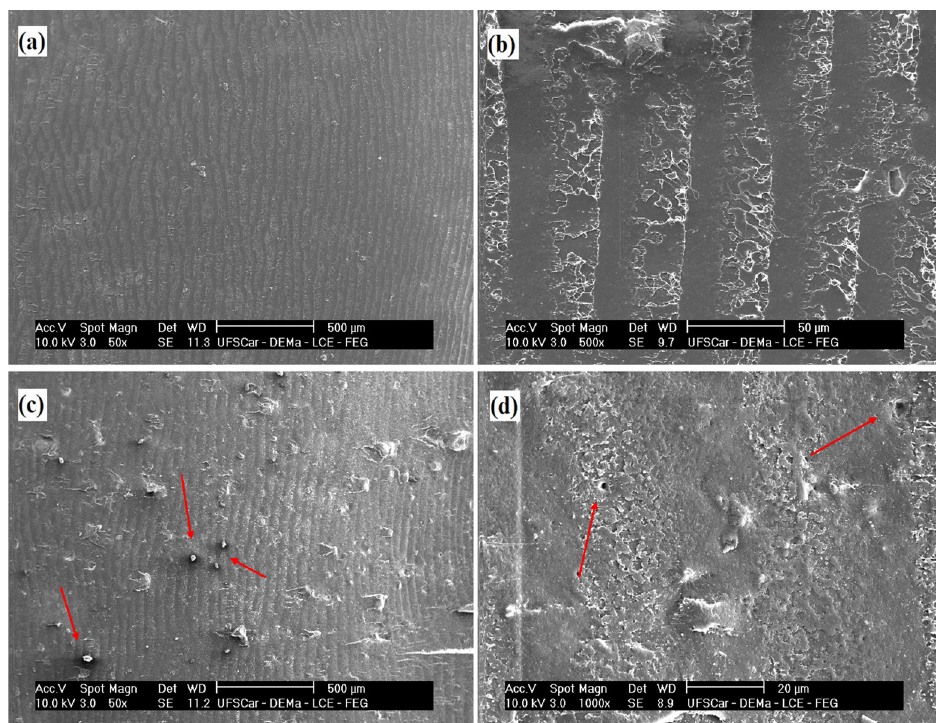
Figure 6. Impact surface SEM micrographs: (a) PLA, (b) PLA/2.5RC, (c) PLA/10RC, (d) PLA/15RC.